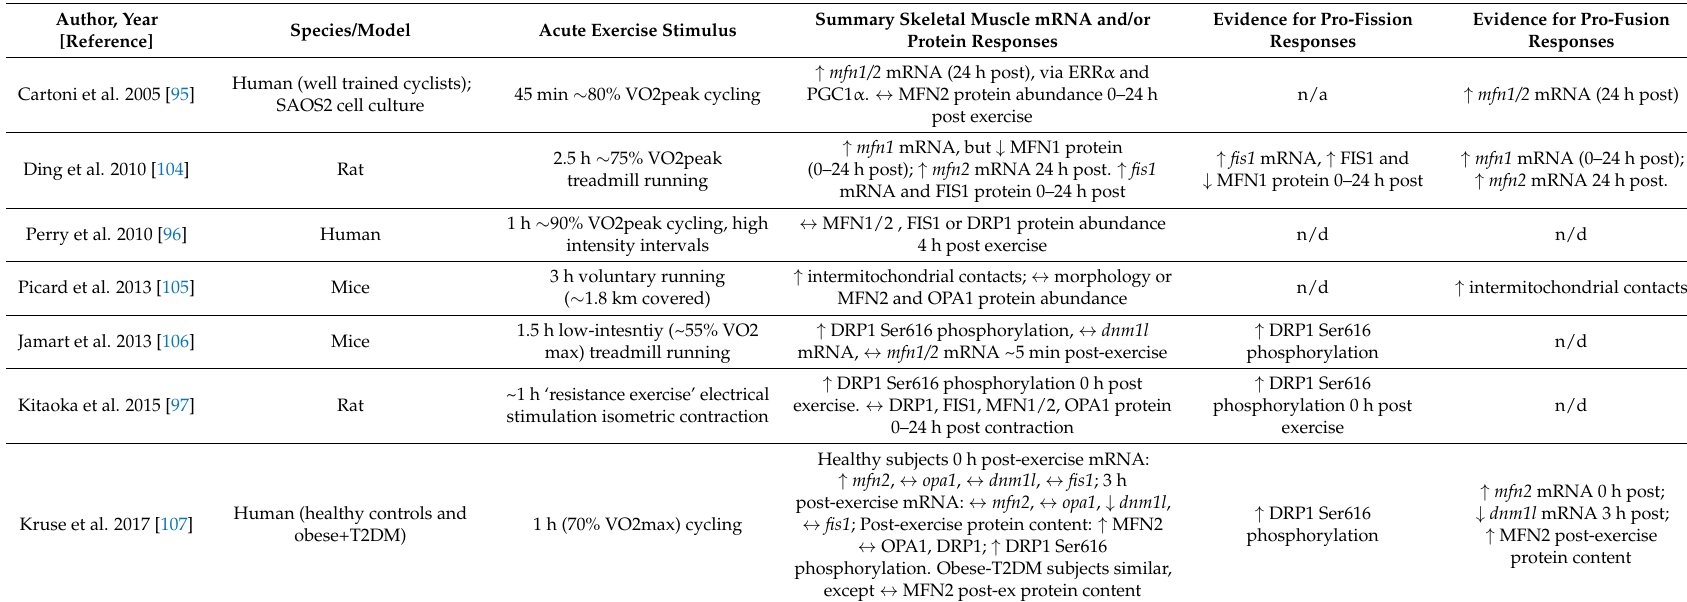
Table 1. Effects of acute exercise on mitochondrial fission/fusion mRNA and protein